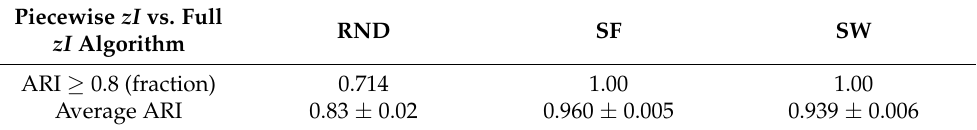
Table 2. The results of the computation of the adjusted Rand index (ARI) among the groupings calcu- lated by full RI method—identified here as the “ground truth”—and the corresponding groupings of the piecewise RI method, for the RND, SF and SW systems. The table shows the fraction of times the piecewise RI method reported an ARI greater than 0.8 and the average of the ARI index. The data confirms the substantial agreement of the two algorithms in the case of KOs, in some cases an almost excellent agreement (SF and SW